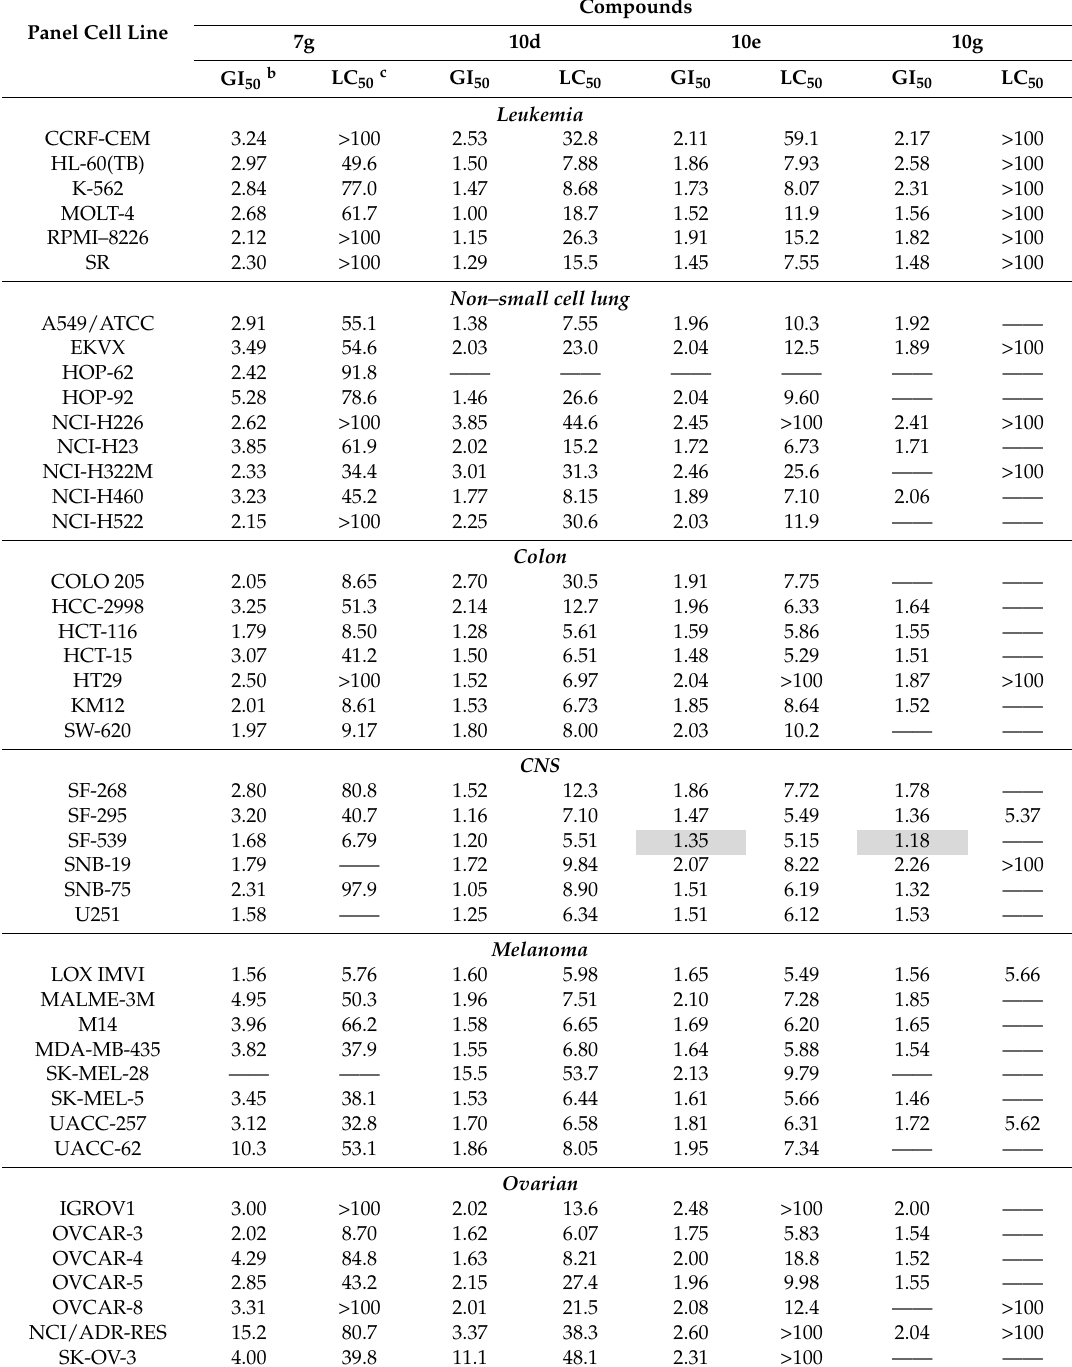
Table 2. In vitro testing expressed as growth inhibition GI 50 and lethal concentration LC 50 of cancer cell lines for compounds 7g and 10e , d , g a